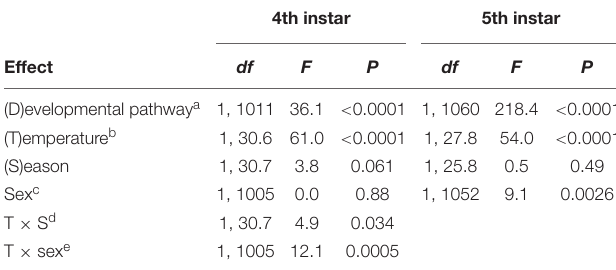
TABLE 3 | Instantaneous growth rates (in second day of the instar) in the 4th and 5th instar Araschnia levana larvae as explained by developmental pathway, temperature, season, and sex; linear mixed models (SAS, Proc MIXED, type 3 sums of squares) with brood (progeny of one female) as a random